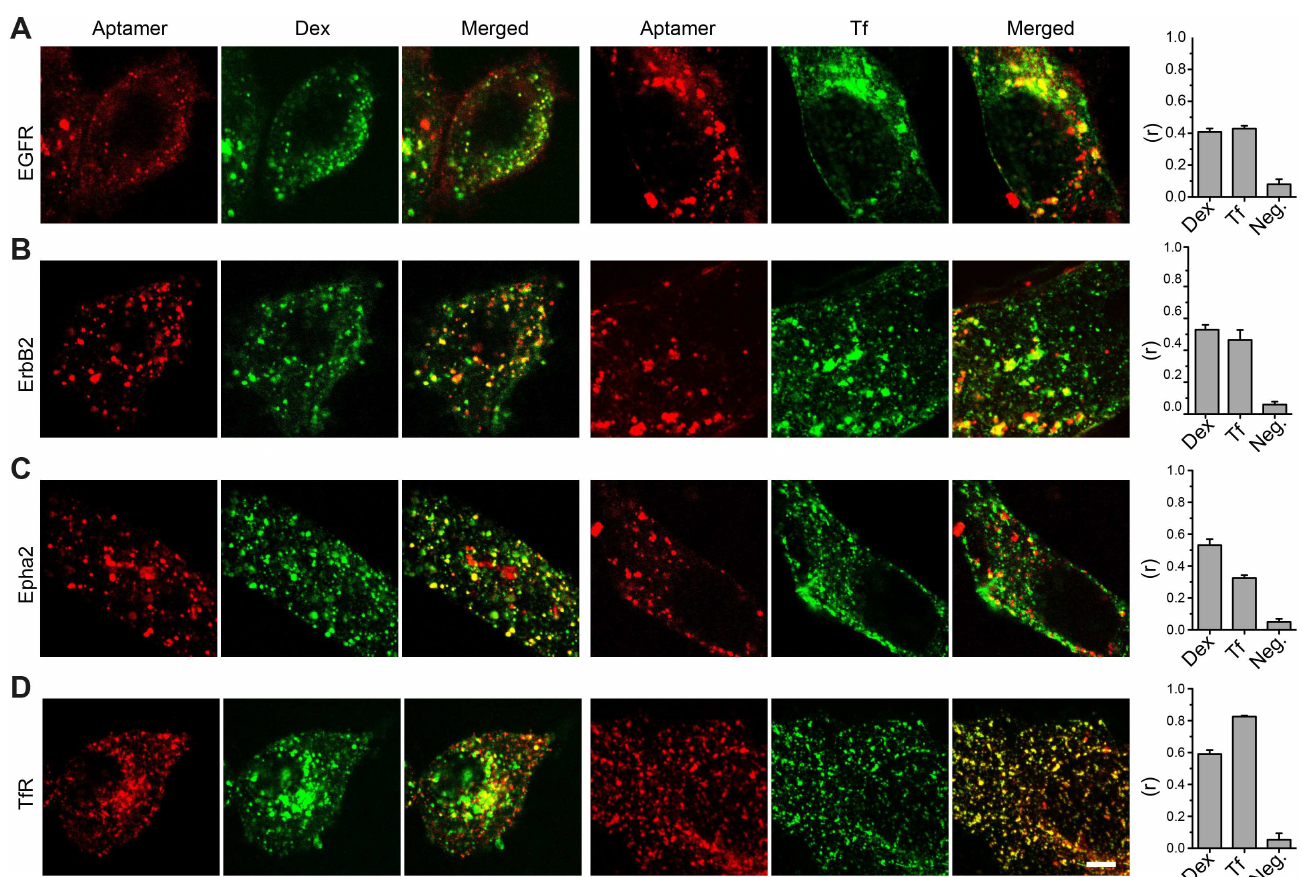
Fig 2. Co-localization of aptamersand classical endocytotic markers. ( A-C ) Confocalimages of cells co-stainedwith aptamers and Alexa488-dextran (Dex) or Alexa488-Transferrin (Tf). ( D ) Confocalimages of a validatedaptamer againstthe transferrin receptor (TfR) [7] on HEK293 cells was used as positive co-localization control with Tf. Pearson’scorrelationscoefficient (r) were calculatedfrom 3 independent experiments (10 to 20 cells analyzedper experiments). The negative control (Neg.) was obtainedby flippingone of the images horizontally before computingthe correlationcoefficient. Bars represent the averageof three independentexperiments and error is the SEM. Scale bar represents5 μ m.